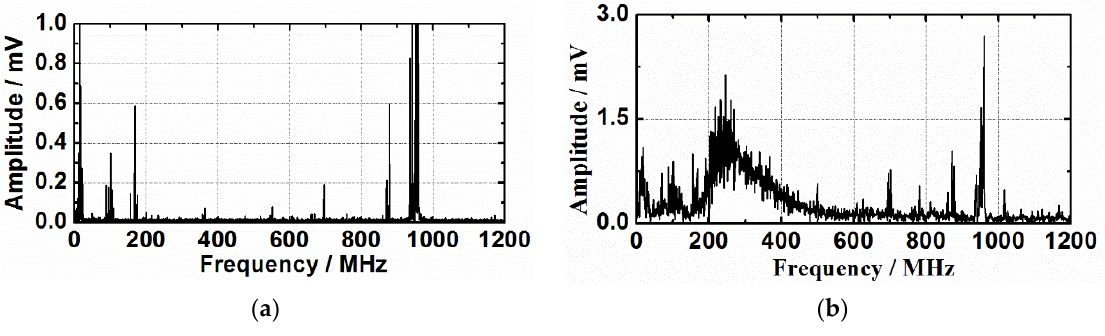
Figure 10. Frequency analysis of ( a ) background; ( b ) signals.